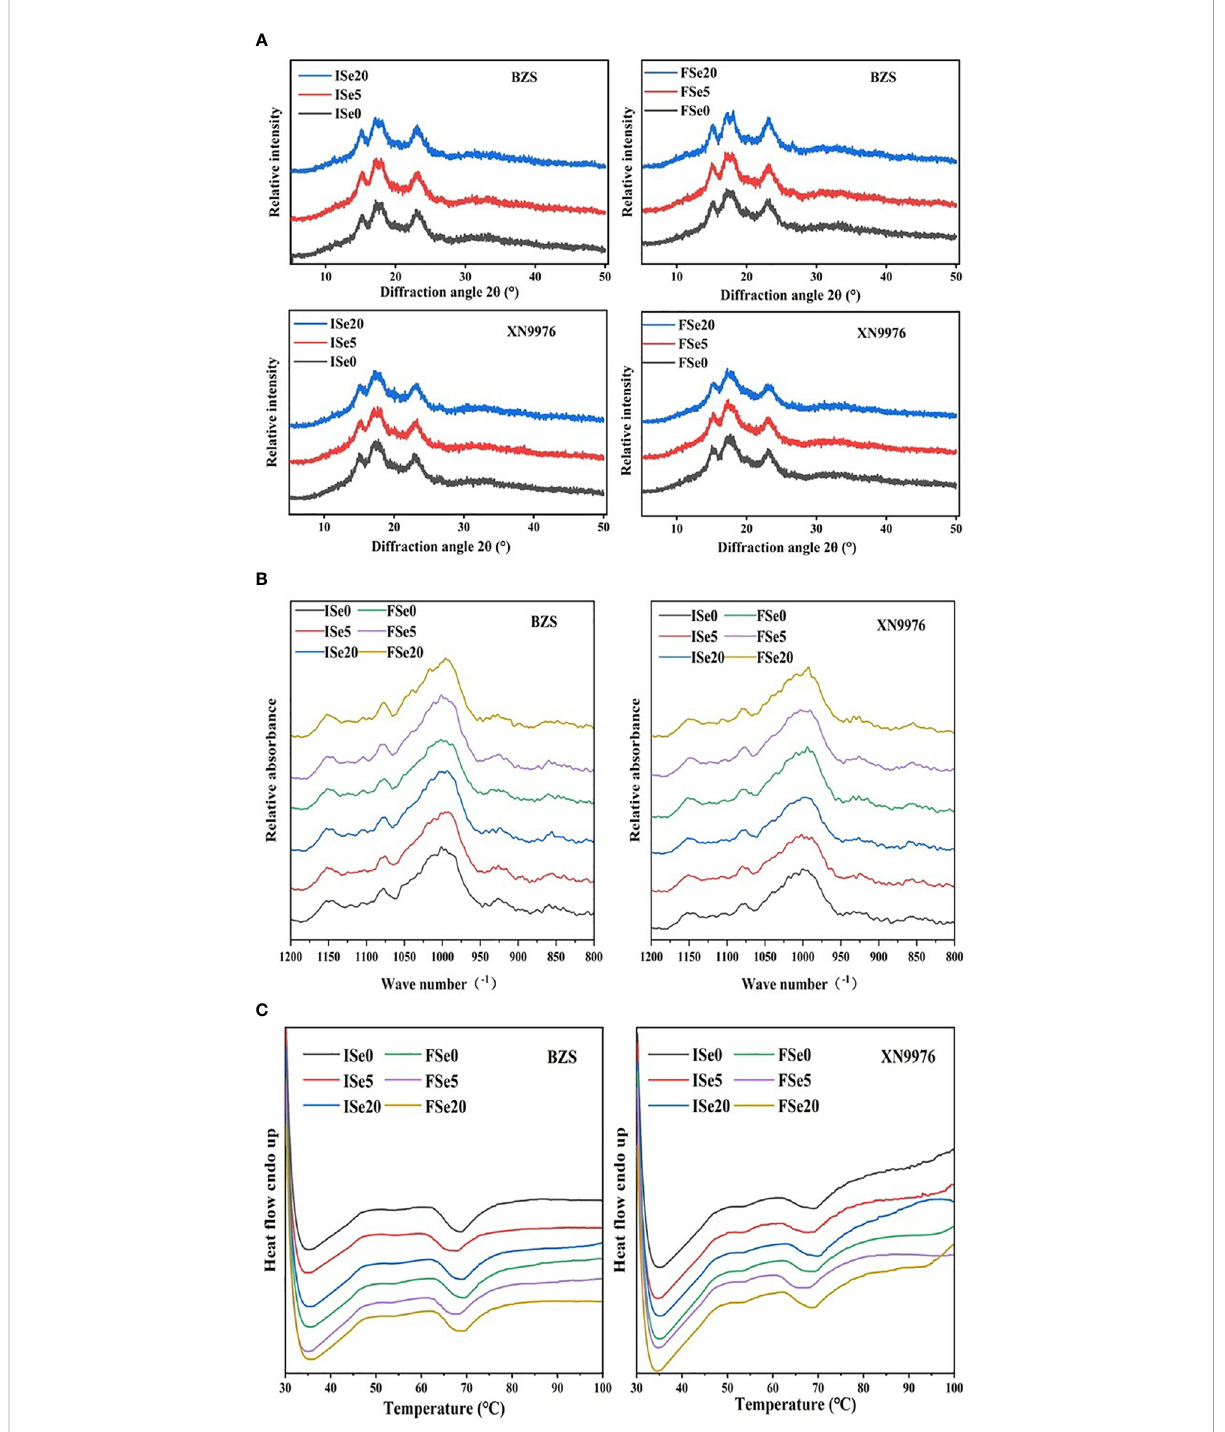
FIGURE 3 (A – C) X-ray diffraction patterns, Fourier peak spectrum and DSC thermogram of common buckwheat starch under different selenium treatment